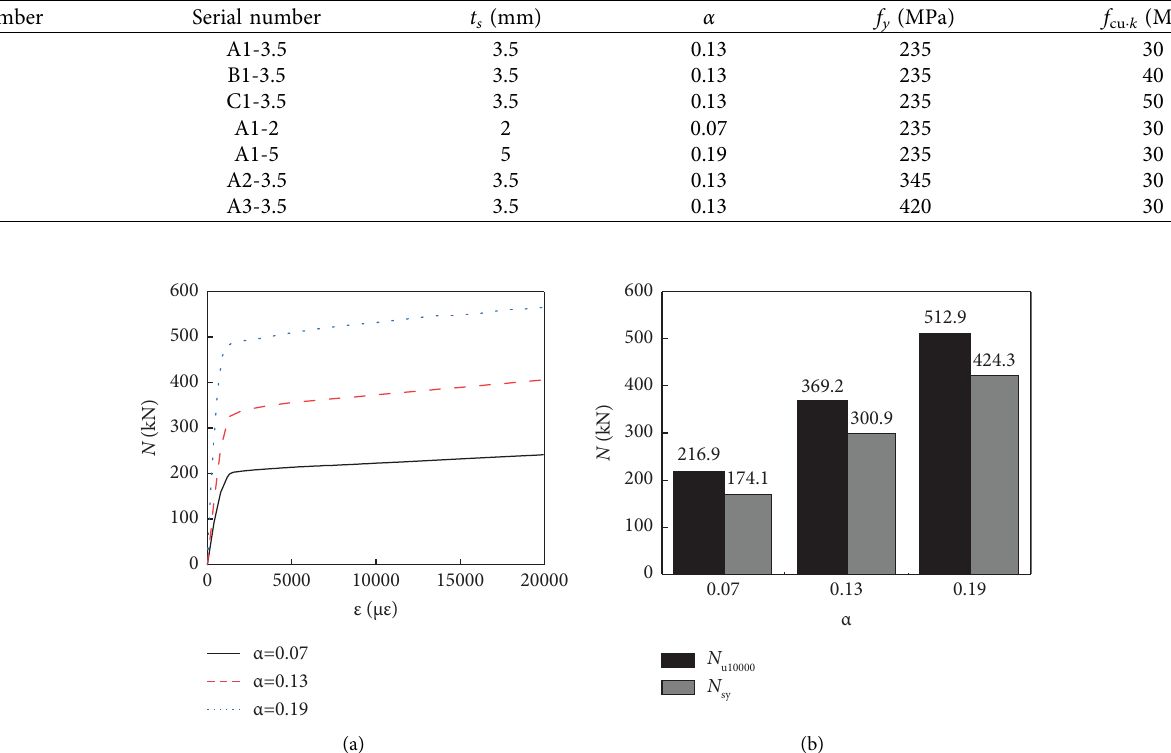
Figure 19: Te infuence of α on the axial tensile properties: (a) N - ε curve of specimen under diferent α and (b) comparison of N N sy under diferent α .